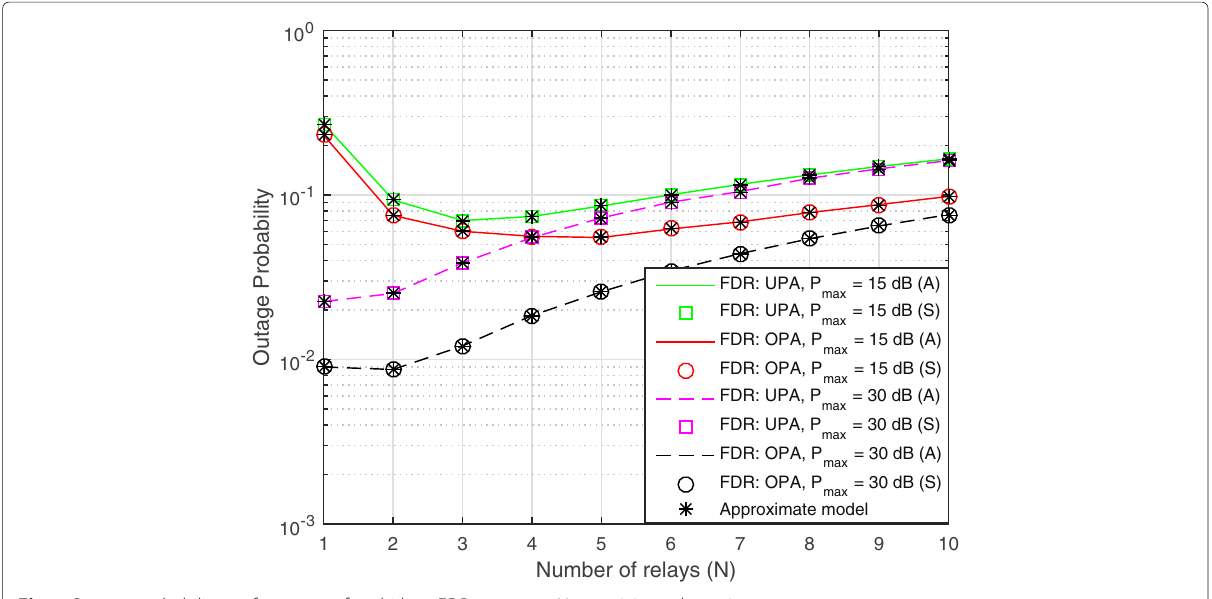
Fig. 5 Outage probability performance of multi-hop FDR system vs N : π 0 = 0.01 and m =